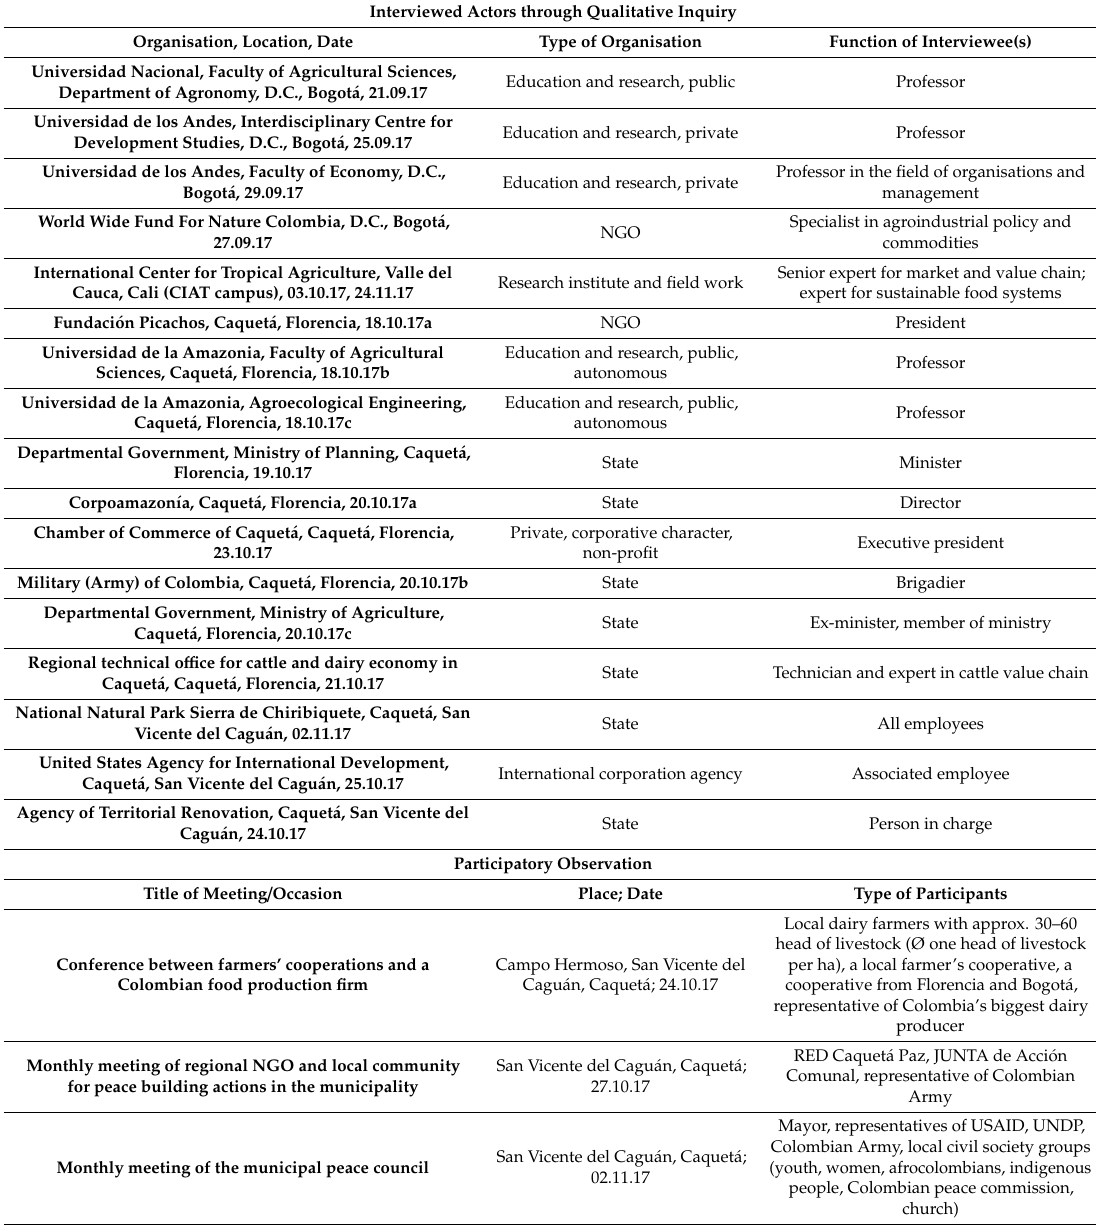
Table 2. Interviewed actors of rural development and occasions for participatory